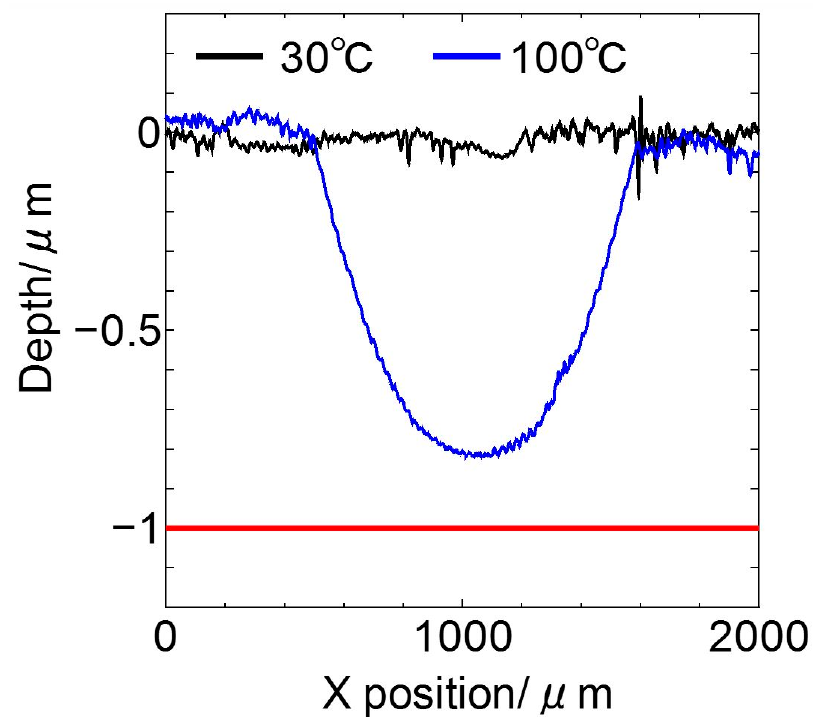
Figure 5. Surface profile of (BMIM)(TCC).